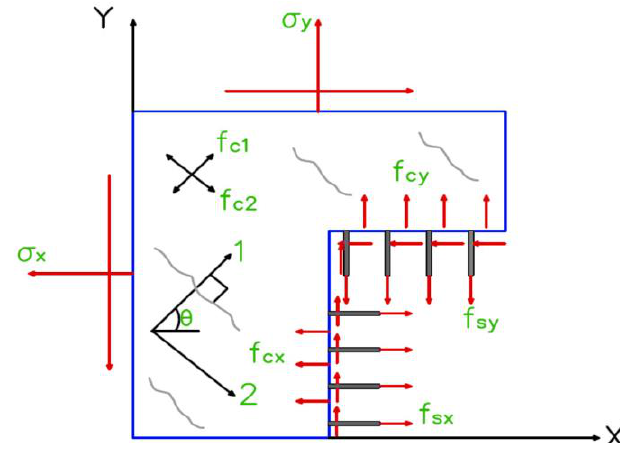
Figure 2. Free-Body Diagram of the Average Stresses in Reinforced Concrete [12,29].